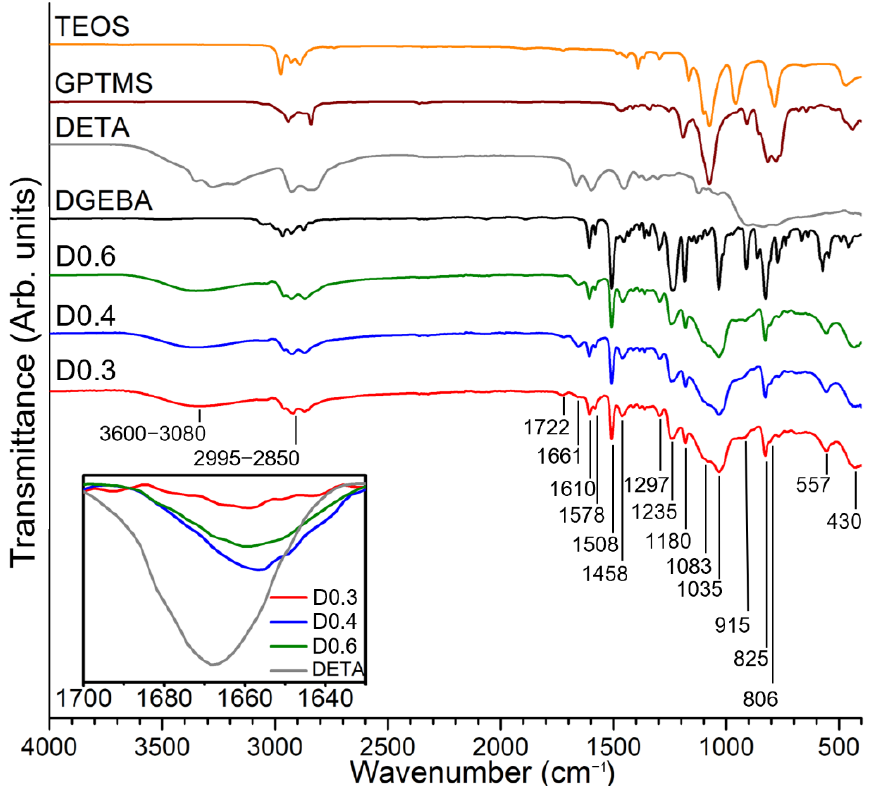
Figure 1. FTIR spectra of the precursor reagents (DGEBA, DETA, GPTMS, and TEOS) and epoxy – silica hybrids prepared with different curing agent/epoxy resin ratios (D0.3, D0.4, and D0.6). Insert: Band at 1661 cm – 1 associated with the N – H bond stretching vibrations of epoxy – silica hybrids compared to the DETA precursor. Table 2. Characteristic bands of epoxy – silica hybrids and precursor reagents.